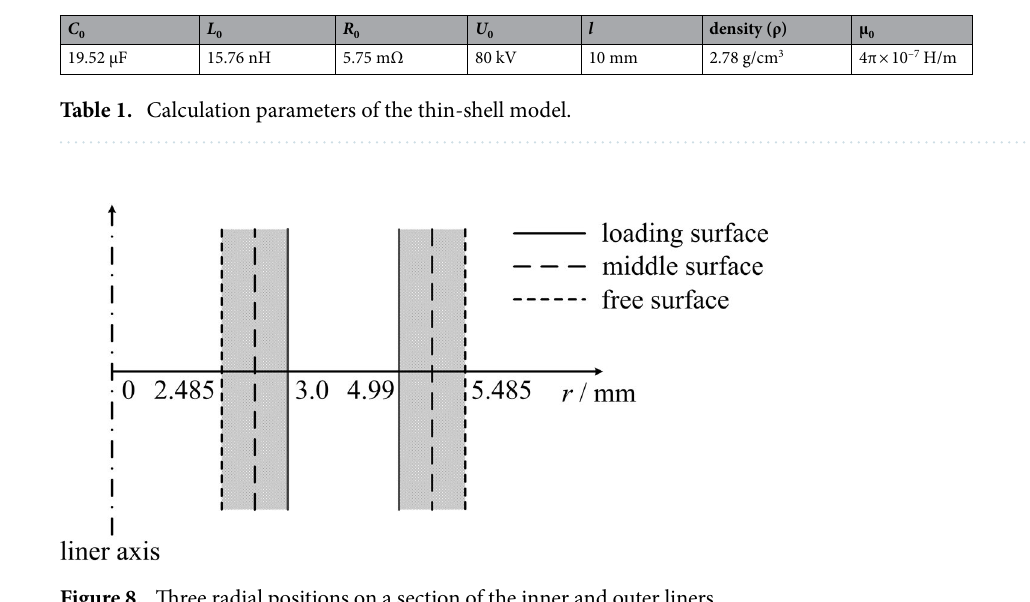
Figure 8. Three radial positions on a section of the inner and outer liners.